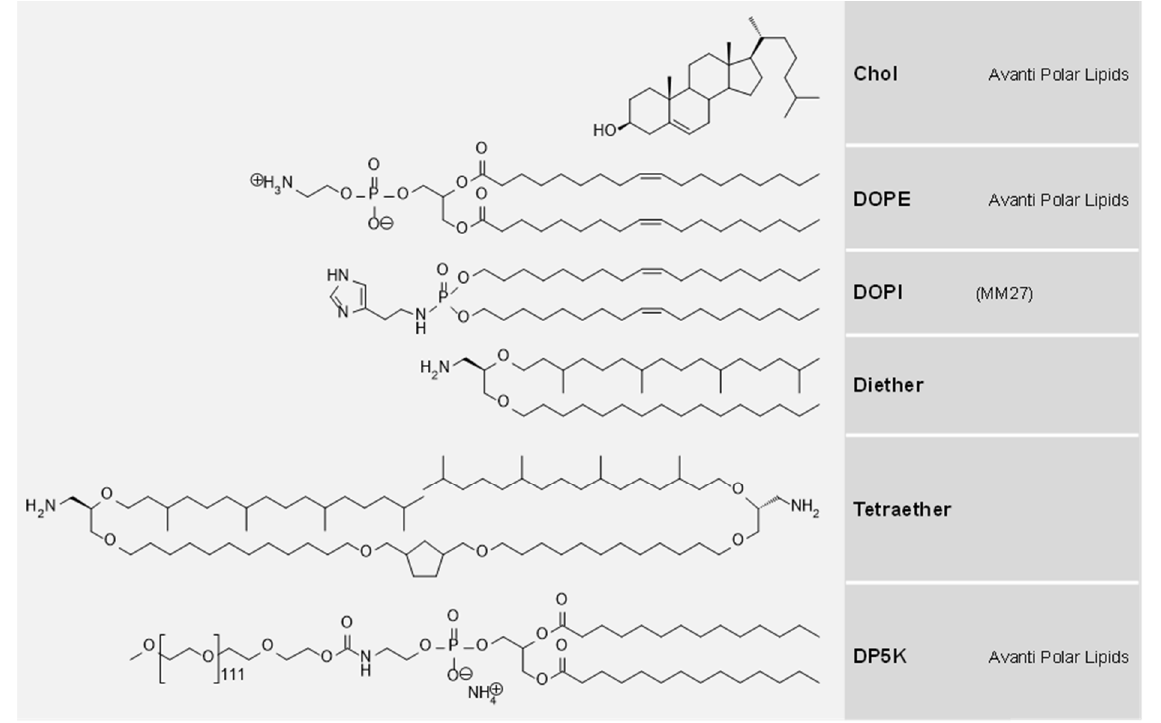
Figure 2. Chemical structure of other compounds used as colipids in this study. Chol, cholesterol; DOPE, dioleyl phosphatidylethanolamine; DOPI, dioleyl phosphoramide imidazole; DP5K, 1,2-dimyristoyl-sn-glycero-3-phosphoethanolamine conjugated polyethylene glycol 5000.